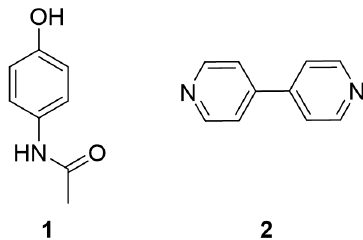
Figure 1. Chemical structures of paracetamol (PCM) ( 1 ) and 4,4 ′ -bipyridine (44BP) ( 2 ).